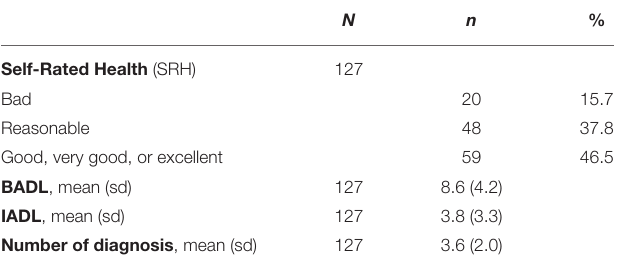
TABLE 2 | Subjective and objective health of the sample.